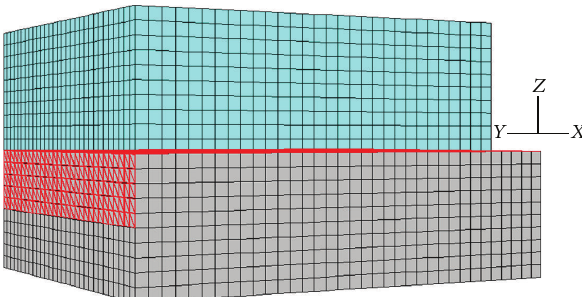
Figure 12: Grid of numerical model for direct shear